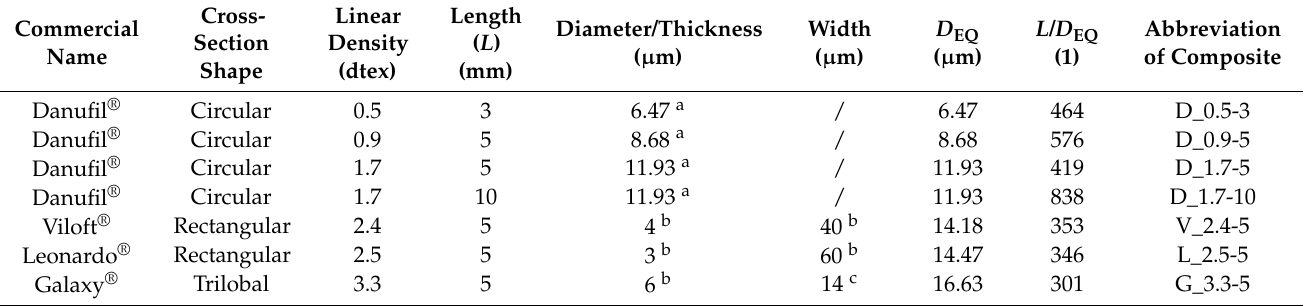
Table 1. Commercial names and geometrical properties of VF and abbreviations of the correspond- ing composites.